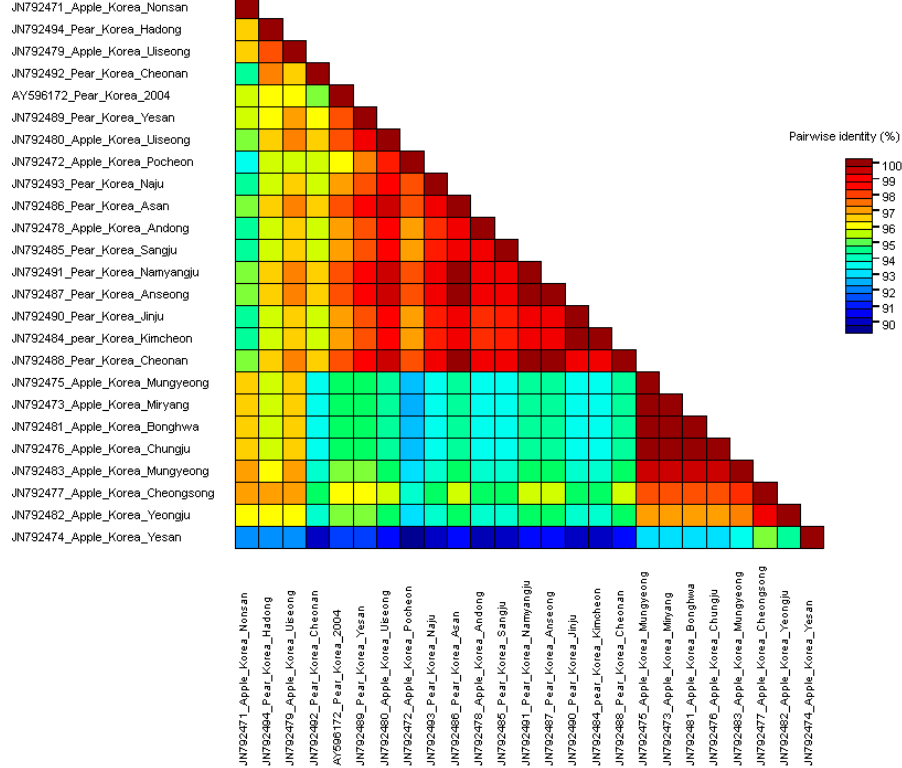
Figure 3. Apple stem grooving virus (ASGV) coat protein amino acid sequence identities. MUSCLE alignment was used implemented in Sequence demarcation tool (SDTV1.2).